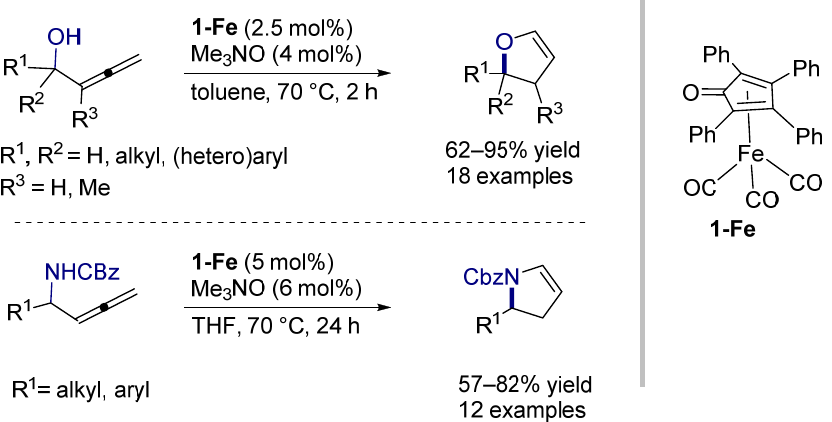
Figure 4. Syntheses of 2,3-dihydrofurans and 2,3-dihydropyrroles by cyclohydrofunctionalization promoted by tetraphenyl-substituted cyclopentadienone iron(0) tricarbonyl precatalyst 1-Fe . In 2019, Marcyk and Cook described a very efficient method for intermolecular C–O